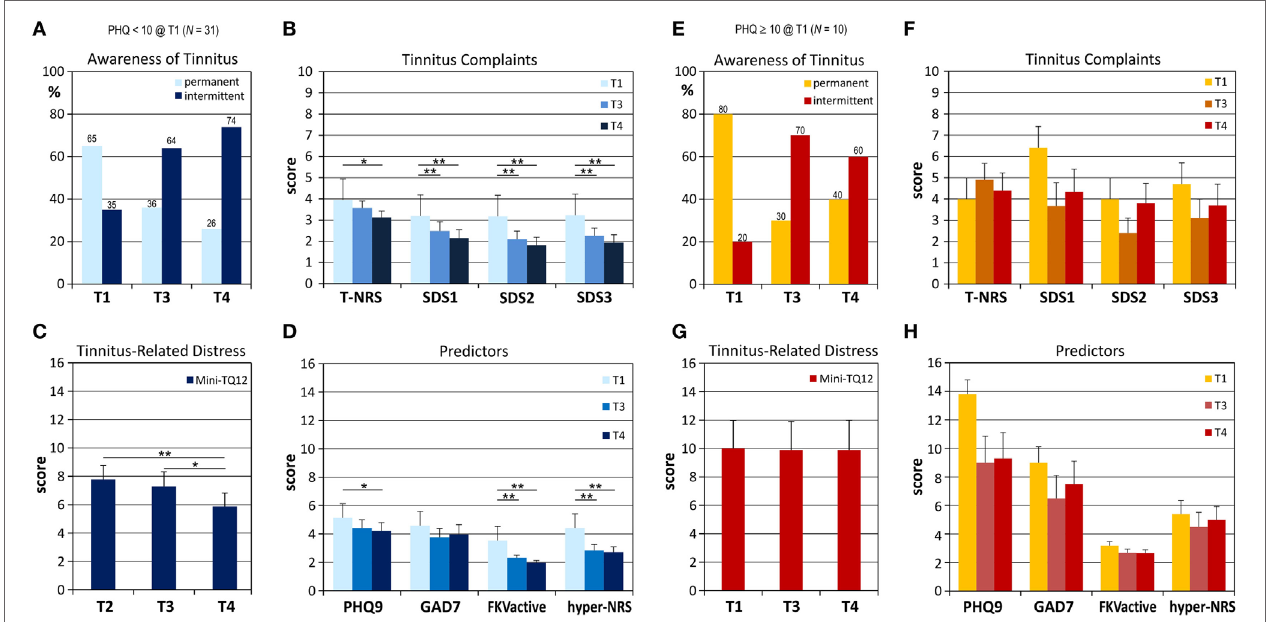
FigUre 2 | Development of tinnitus complaints and variables that were identified as predictors for future tinnitus intensity for the group with low to moderate levels of depression [ (a–D) , blue columns], and the group with high levels of depression, [ (e–h) , orange-red bars]. Means and respective SEs are shown. (a,e) Awareness of the tinnitus, (B,F) perceived tinnitus loudness (T-NRS), and distress as assessed by the Sheehan scales (SDS), and (c,g) with the Mini-TQ12. (D,h) Predictor variables are levels of depression (PHQ9) and anxiety (GAD7), active coping with illness (FKVactive) and oversensitivity to sound (hyper-NRS). Values for all tinnitus measures dropped in the group with low PHQ9 scores at T1 with all reductions reaching statistical significance, while there was no significant decrease for these factors in the group with high depression levels. Also, scores of all predictor variables dropped significantly in the former while any reduction observed in the latter group did not reach statistical significance between assessments. * p < 0.05; ** p <